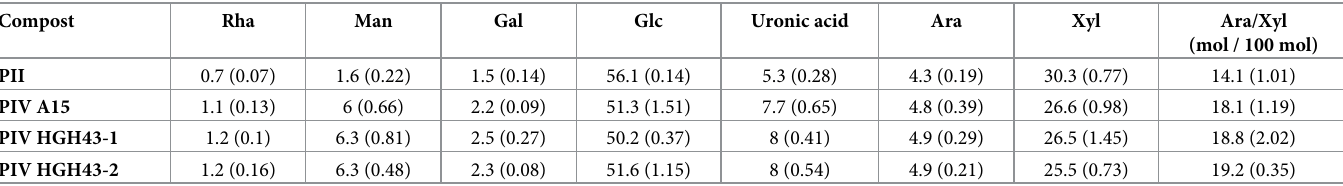
Table 1. Carbohydrate composition (mol / mol %) of compost.